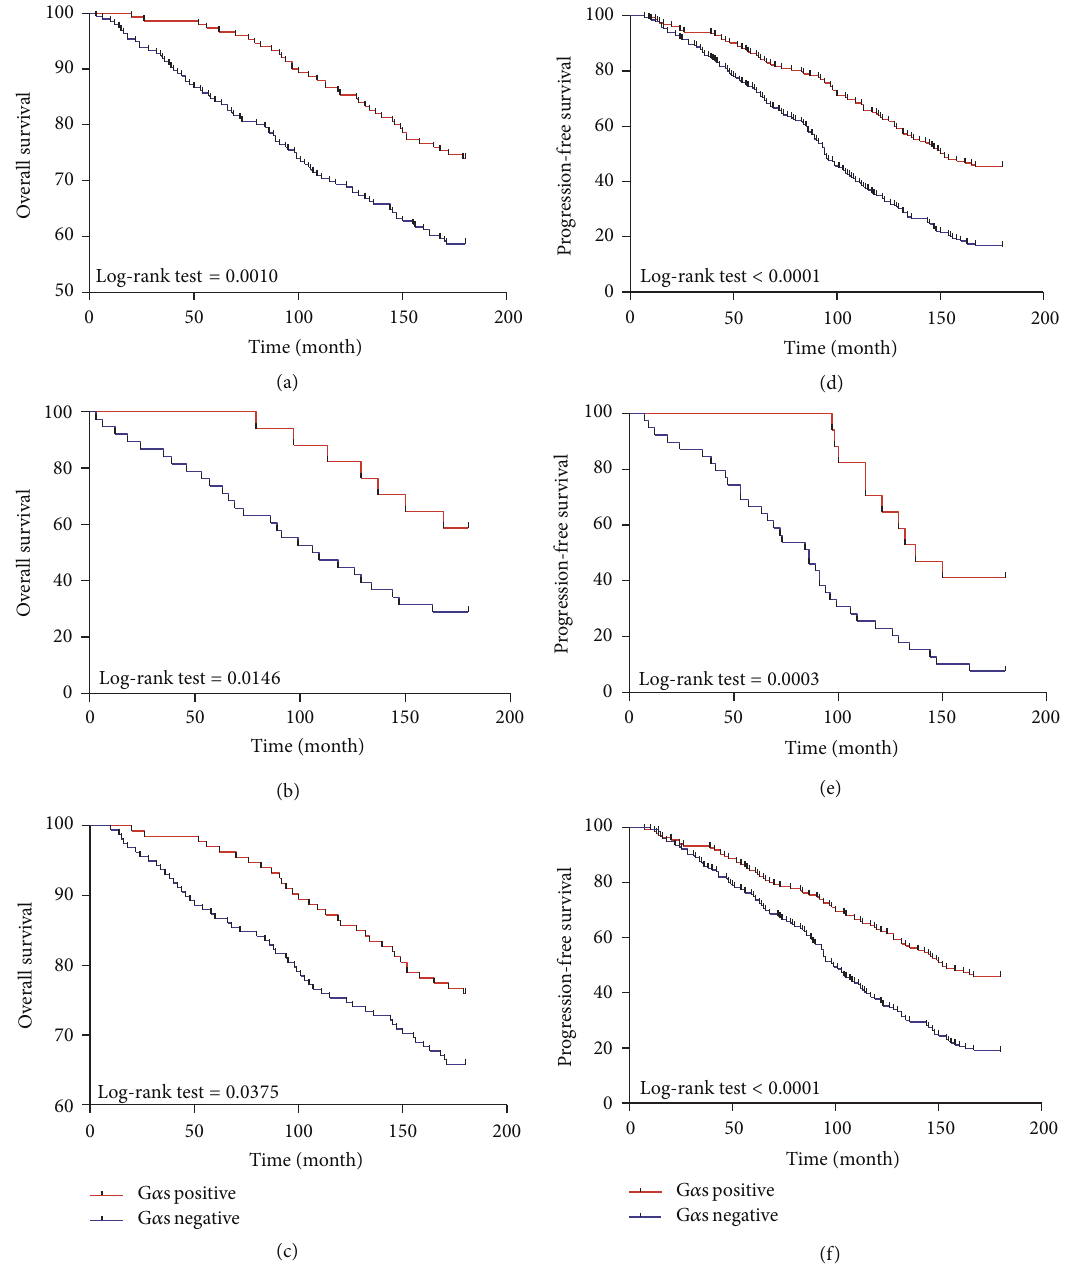
Figure 2: Kaplan-Meier analysis of overall survival (cumulative survival) and PSA progression-free survival of PCa patients relative to G 𝛼 s expression. (a) Correlation of G 𝛼 s expression with overall survival; (b) in metastatic PCa specimens, the correlation of G 𝛼 s expression with overall survival; (c) in localized PCa specimens, the correlation of G 𝛼 s expression with overall survival; (d) correlation of G 𝛼 s expression with PSA-free survival; (e) in metastatic PCa specimens, the correlation of G 𝛼 s expression with PSA-free survival; (f) in localized PCa specimens, thecorrelationofG 𝛼 sexpressionwithPSA-freesurvival.AstatisticallysignificantdifferenceisshowninoverallsurvivalandPSAprogression- free survival outcome between the different groups of patients, with those having positive expression of G 𝛼 s having the better overall survival and PSA progression-free